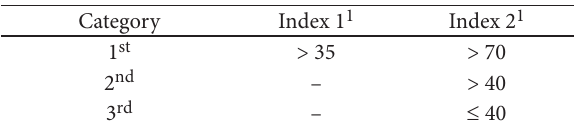
Table 4. Classification of low-volume roads in terms of indices 1 and